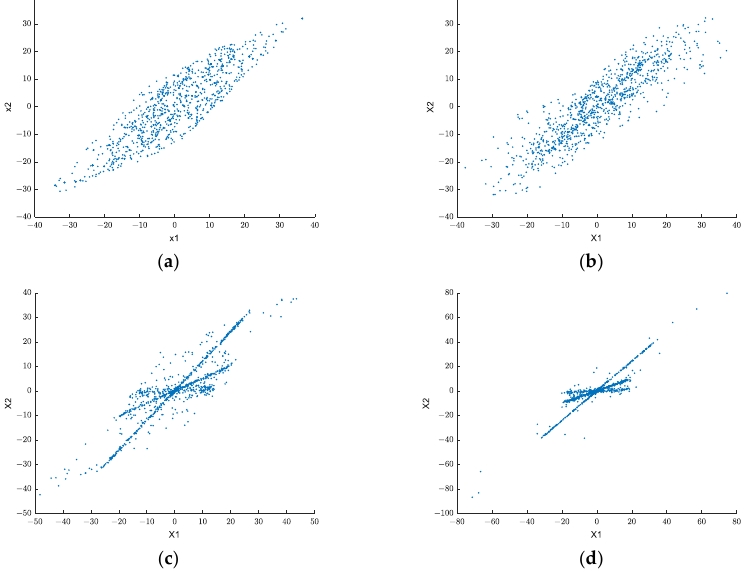
Figure 9. Scatter plot comparison of mixed signals. ( a ) time domain; ( b ) frequency domain; ( c ) frac- tional domain proposed in [34]; ( d ) fractional domain proposed in our paper.